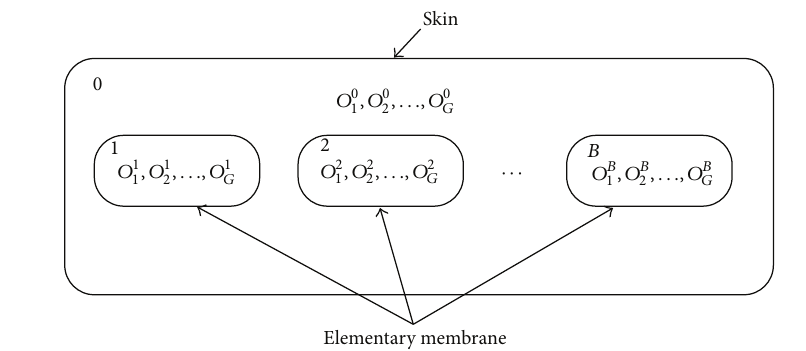
Figure 4: Membrane